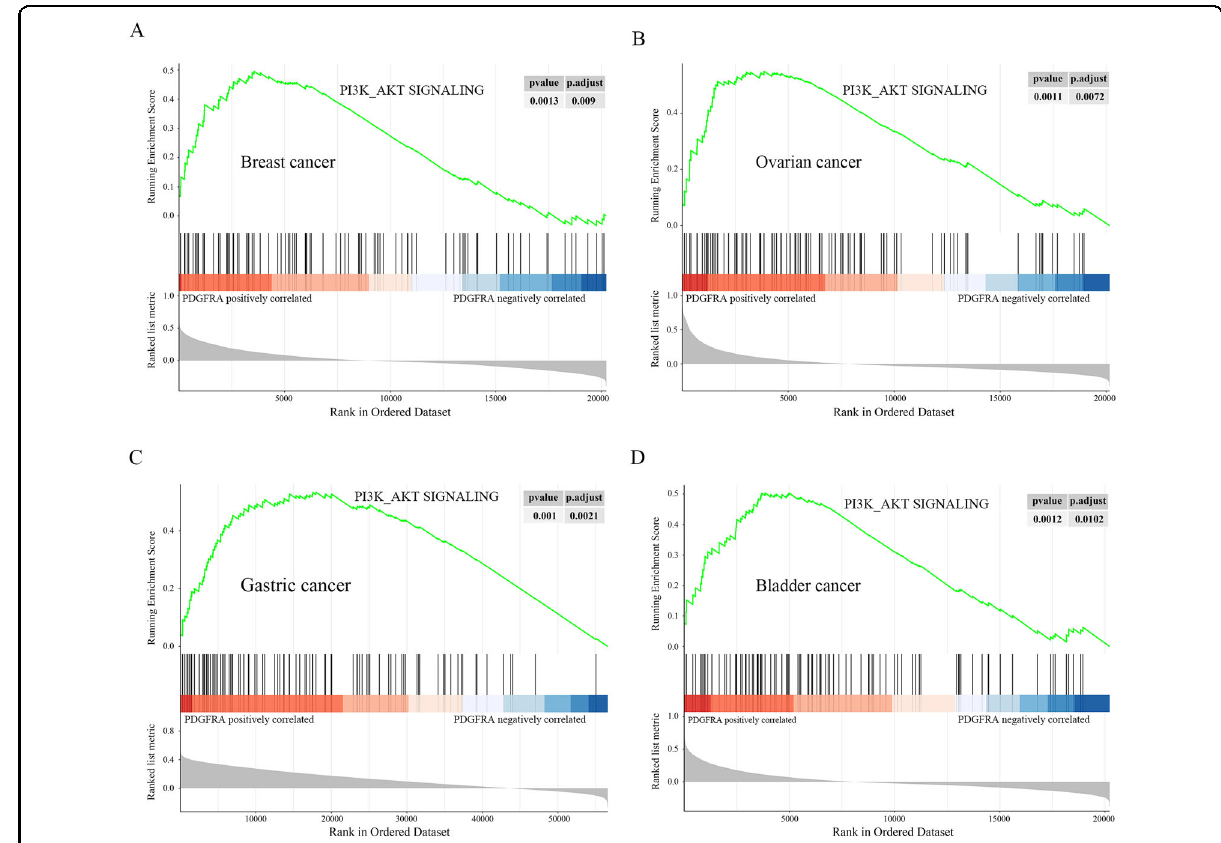
Fig. 6 PDGFR α expression positively correlates with PI3K/AKT signaling pathway activity in multiple human cancer tissues. Gene set enrichment analysis (GSEA) comparing the gene sets positively regulated by PI3K/AKT signaling in PDGFR α -high and PDGFR α -low breast cancer ( A ), ovarian cancer ( B ), gastric cancer ( C ), and bladder cancer ( D ) patients, based on The Cancer Genome Atlas (TCGA) RNA-seq datasets. Genes positively correlated with PDGFR α are shown on the left (red zone). Genes negatively correlated with PDGFR α are shown on the right (blue